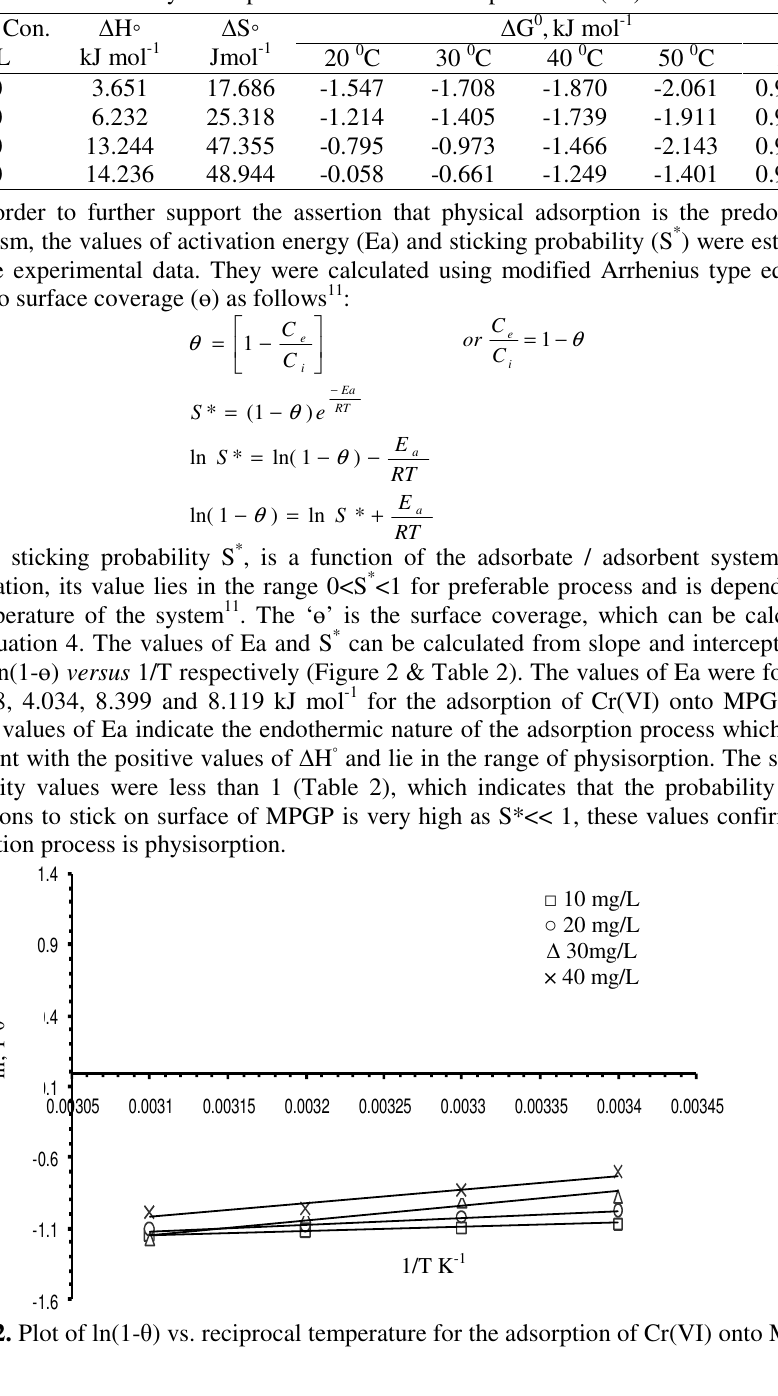
Table 1. Thermodynamic parameters for the adsorption of Cr(VI) on to MPGP.